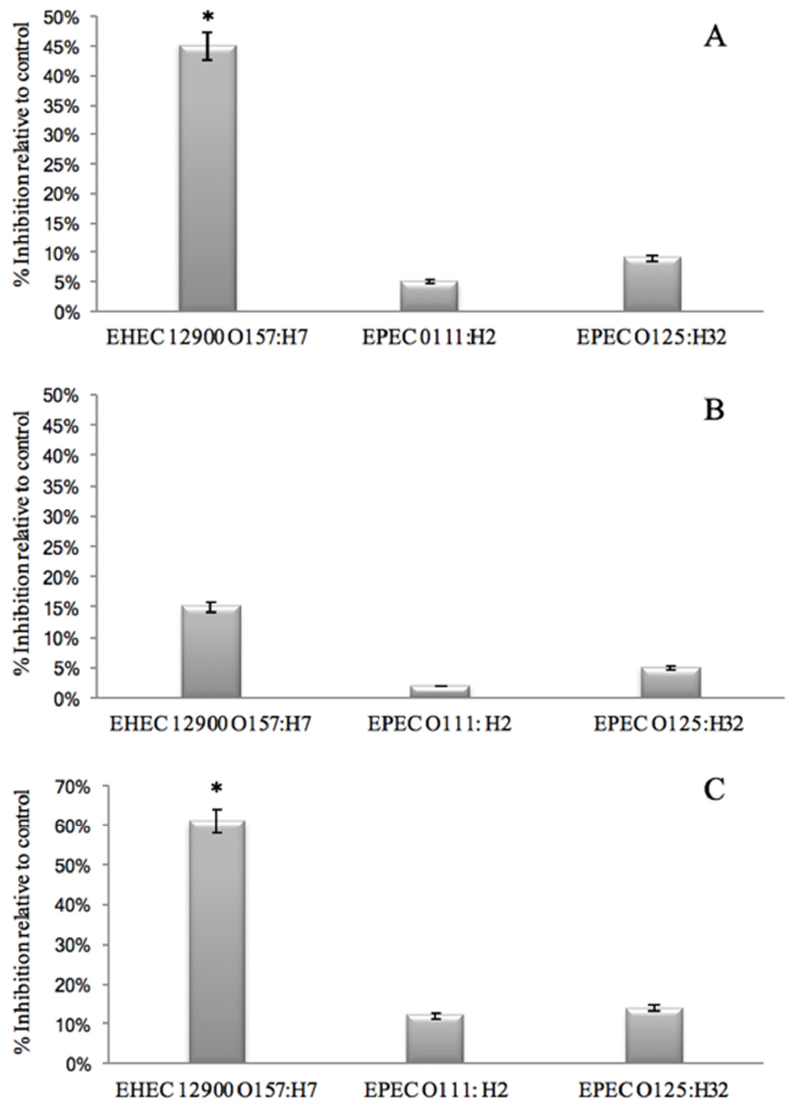
Figure 2. The effect of GMP on the association of E. coli strains with HT ‐ 29 cells. ( A ) Effect of pre ‐ incubation of bacteria with the GMP for 1 h. ( B ) Effect of pre ‐ incubation of HT29 cells with GMP prior to bacterial infection. ( C ) Effect of no pre ‐ incubation step on anti ‐ adherence effect of GMP (* p < 0.05). EHEC = enterohemorrhagic E. coli ; EPEC = enteropathogenic E. coli .